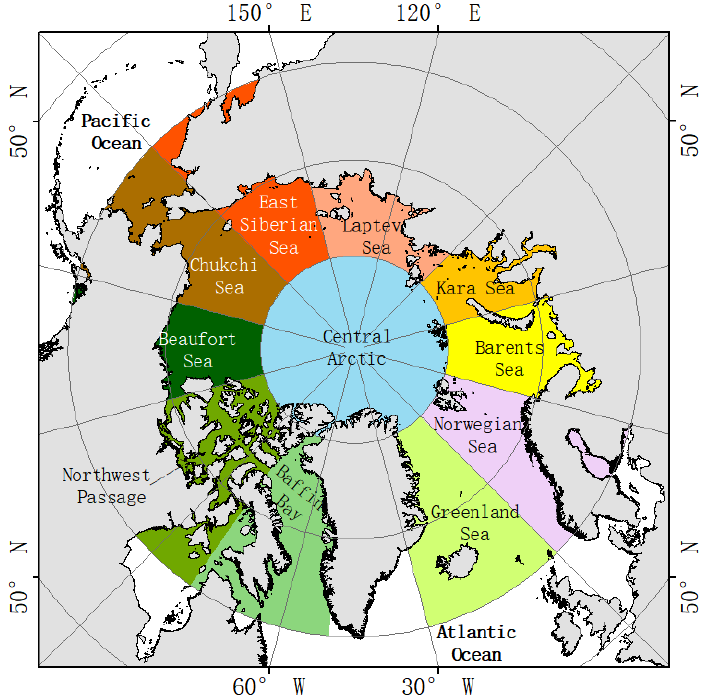
Figure 1. Location of Arctic marginal seas in the study area.